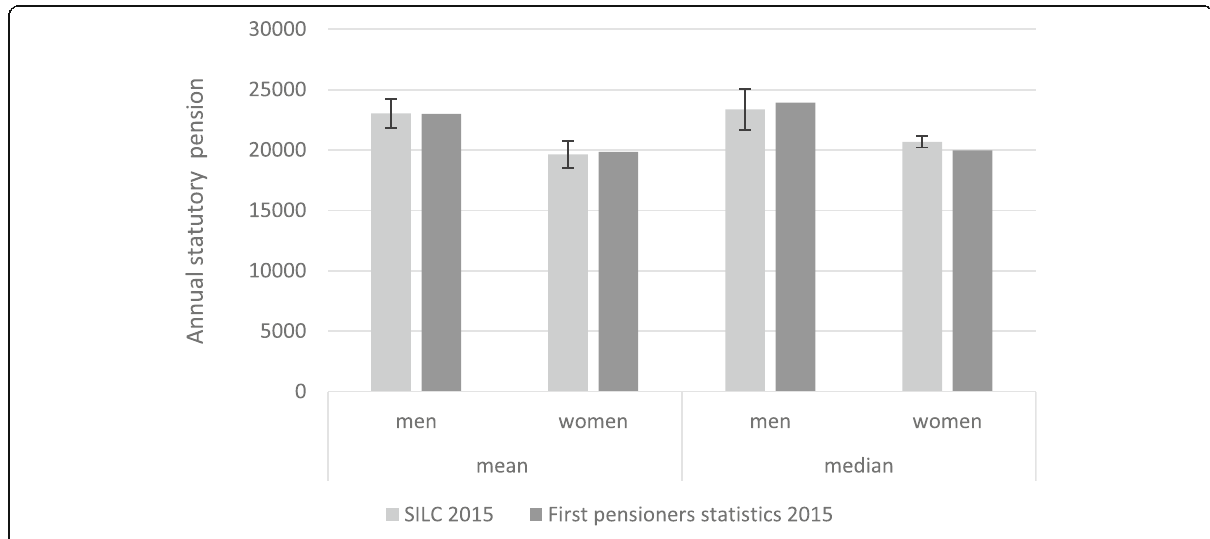
Fig. 1 Accuracy of first pillar pension wealth of retired individuals Note: SILC sample: individuals who reached regular retirement age in 2014 ( n = 125 women, 101 men). Widower pension excluded, survey weights applied. New pension statistics: individuals before or at regular retirement age who received their first pension in 2015 ( n = 40,966 men; 44,116 women), weighted average. Source: CH-SILC 2015 (own calculation) and Swiss Federal Statistical Office